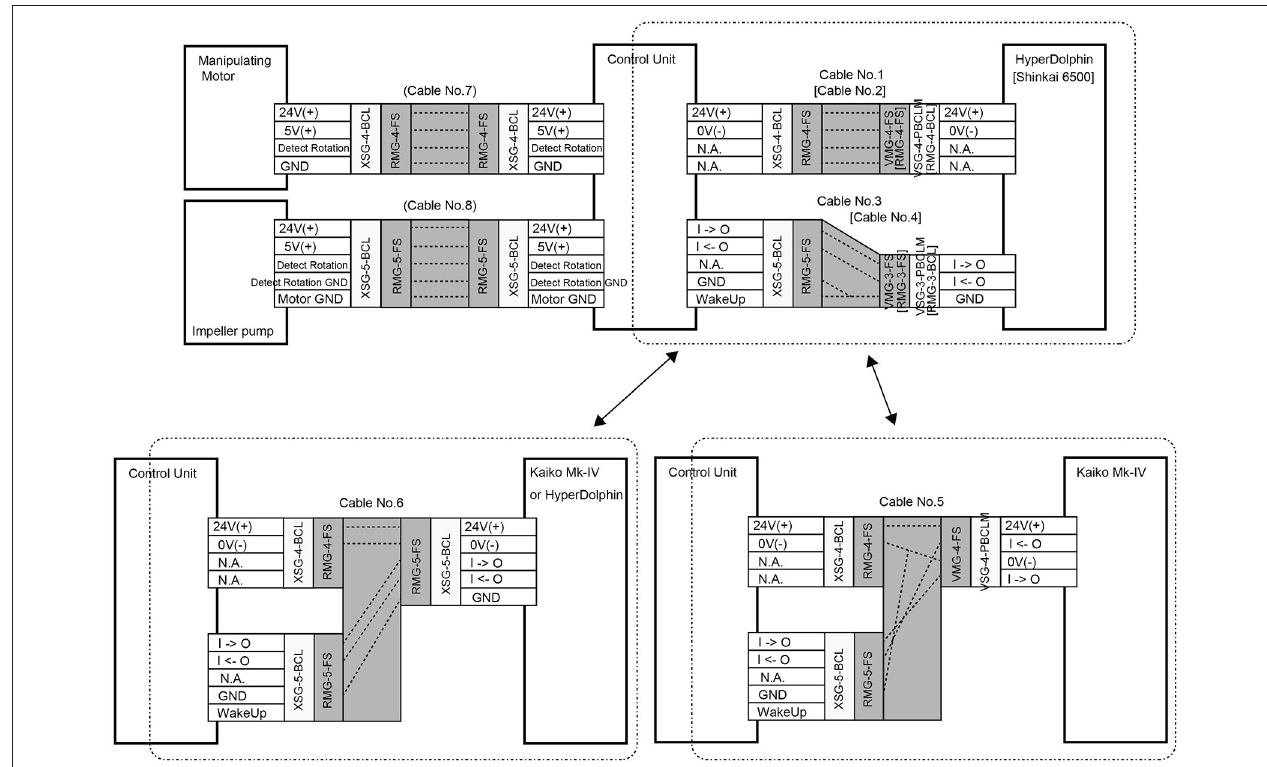
FIGURE 3 | Construction of electronics in Japanese deep-diving